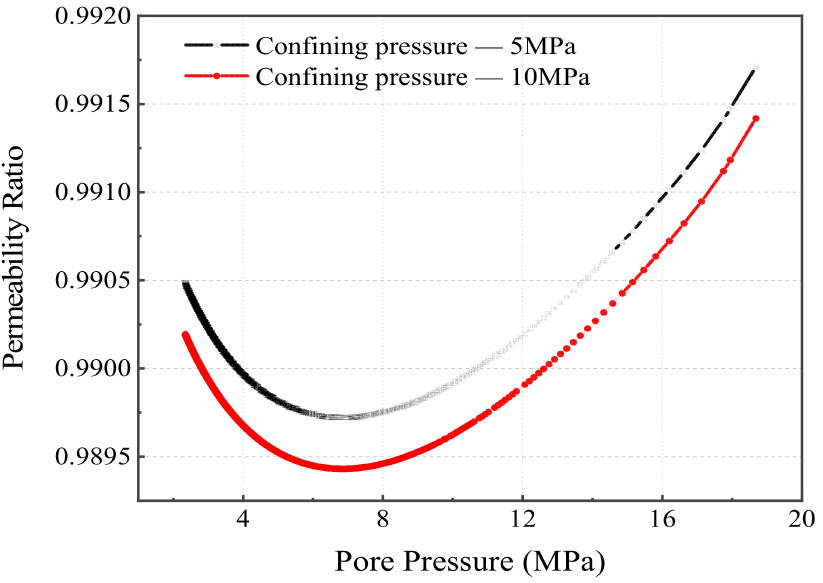
Figure 6. Permeability change curve under different confining pressures considering sorption- induced strain case.